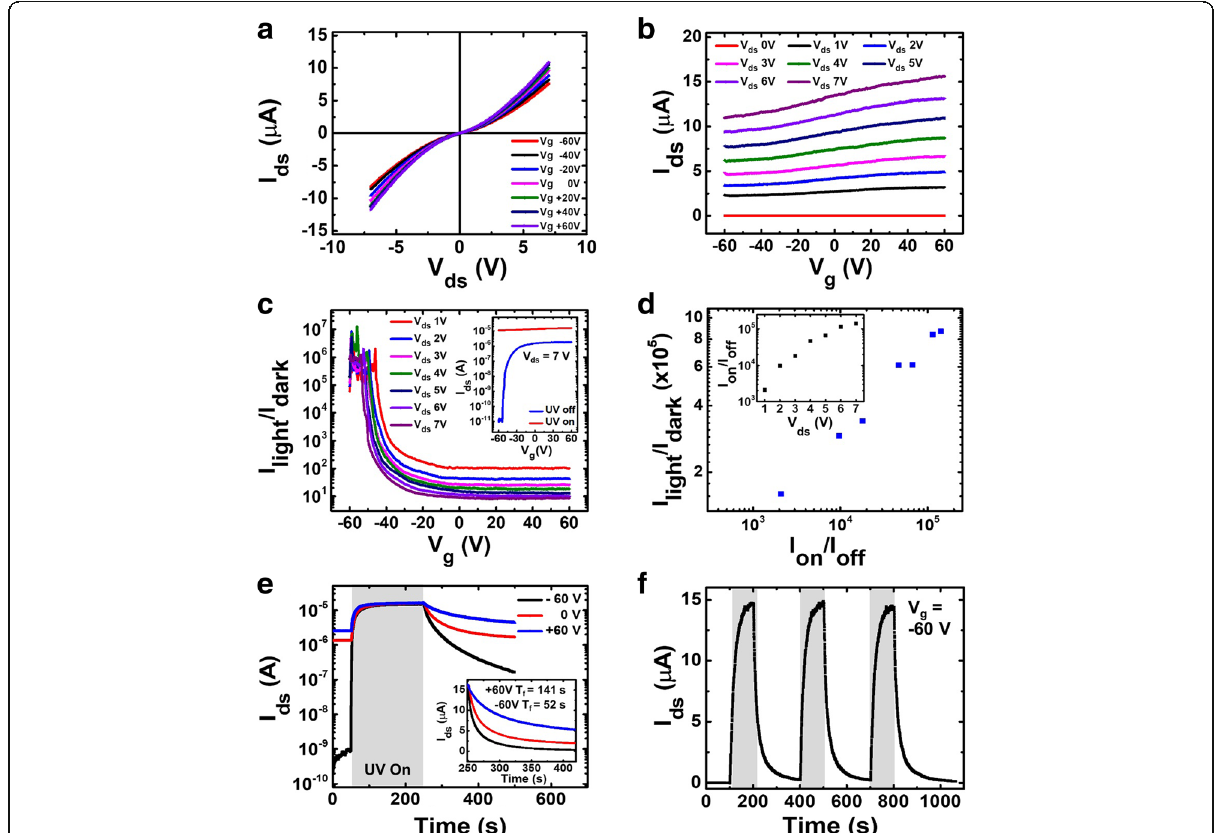
Fig. 5 UV sensing characteristics of ZnO NW FETs. a I – V characteristics under UV illumination at different back-gate voltages. V g ranged from − 60 V to 60 V in 20 V steps. b Electrical properties of I ds vs V g under UV illumination. c I lignt / I dark as a change of gate voltage. Maximum I lignt / I dark was obtained around V g ~ − 55 V. Inset, I ds - V g characteristics under UV illumination and under darkness. d Linear relationship between photo/ dark current ratio ( I lignt / I dark ) and initial on-off current ratio ( I on / I off ) of the ZnO NW FET. The inset shows the initial I on / I off ratio for various V ds . The maximum I on / I off ratio was at V ds = 7 V. e Photoresponse of ZnO NW network FET photodetector with and without UV illumination in the air. The inset shows exponential decay characteristics after the UV light off. f Time-resolved photoresponse of the ZnO NW network channel devices recorded by switching on and off the UV